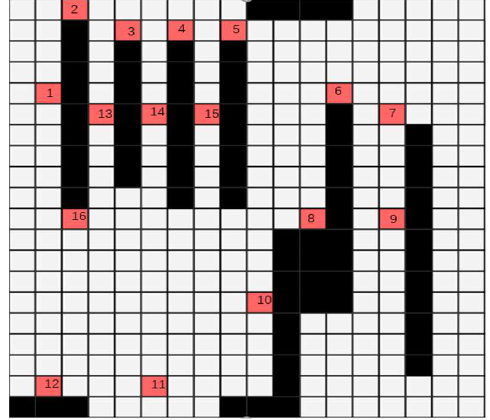
Figure 4. Raster diagram with workstation nodes.